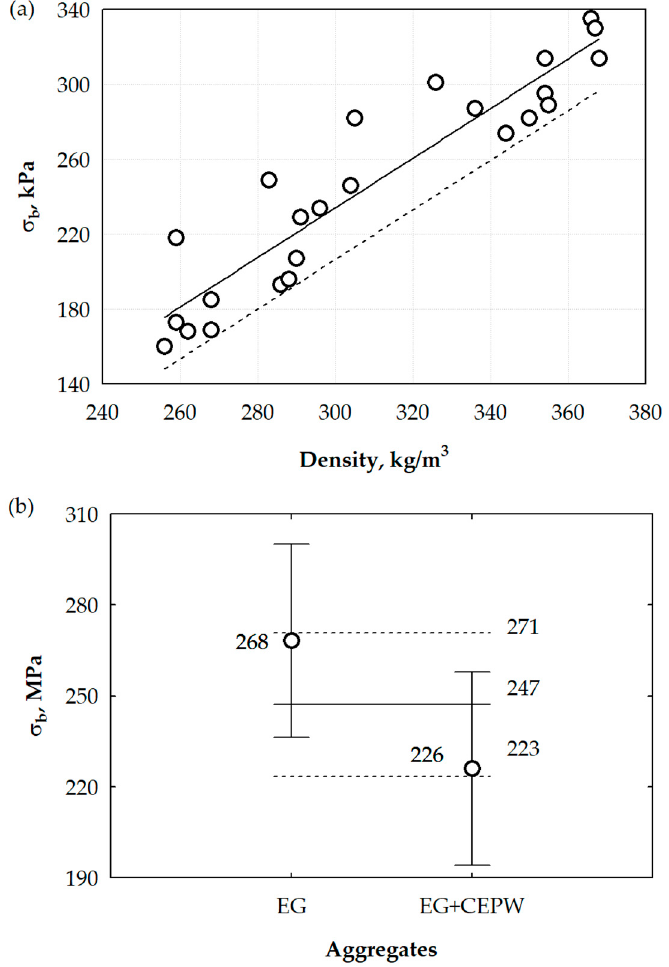
Figure 4. Dependence of the bending strength on density ( a ) and analysis of the effect of CEPW on the bending strength ( b ).